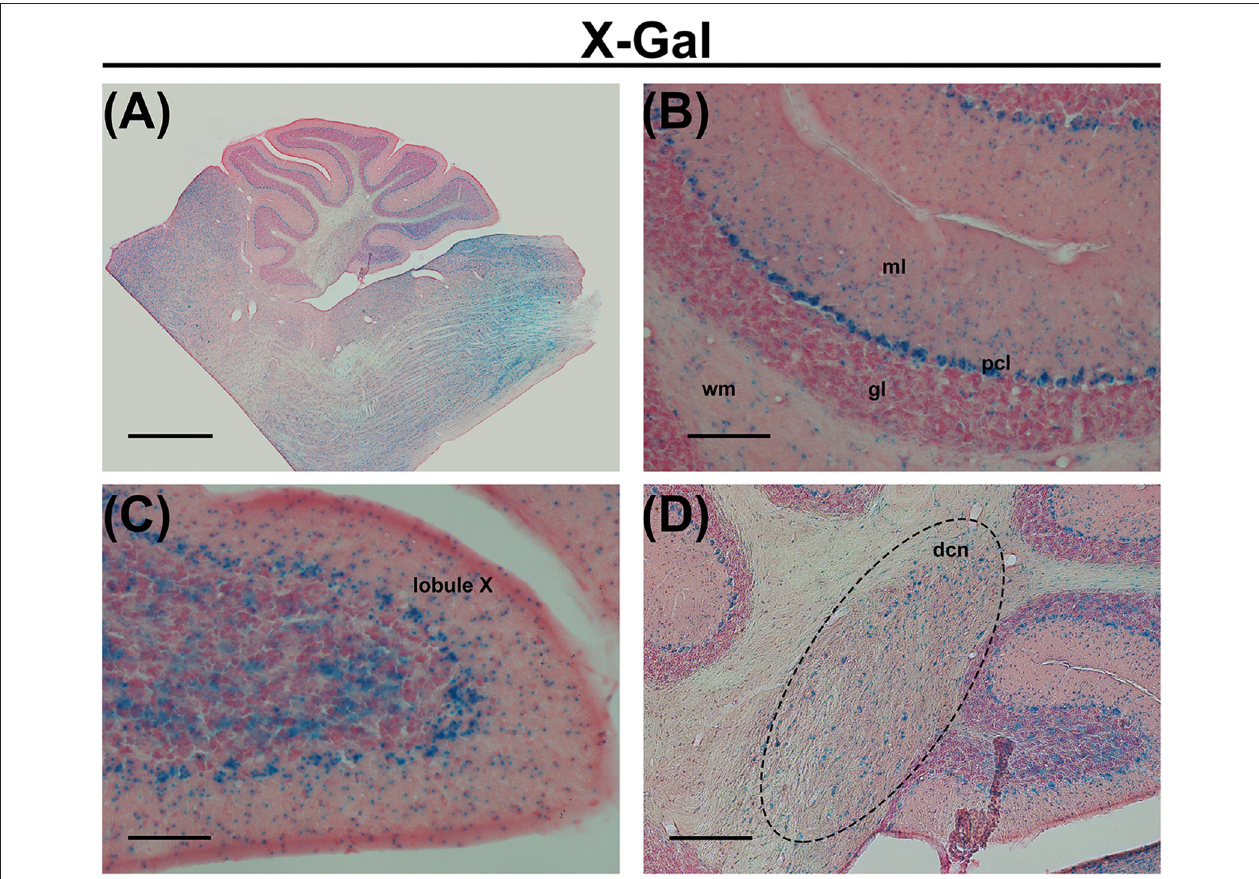
FIGURE 1 | (A) X-Gal staining of a cerebellar slice of an Elovl5 − / − mouse. (B) Higher magnification of the cerebellar cortex, showing X-Gal positive cells in the deeper part of the molecular layer, Purkinje cells (PCs), sparse cells in the granule cell layer and cells in the white matter. (C) Higher magnification of the lobule X showing X-Gal positive cells also in the granular layer. (D) Higher magnification of deep cerebellar nuclei showing X-Gal positive cells. ml (molecular layer); pcl (PC layer); gl (granular layer); wm (white matter); dcn (deep cerebellar nuclei). Calibration bars: (A) 1000 µ m; (B,C) 100 µ m; (D) 200 µ